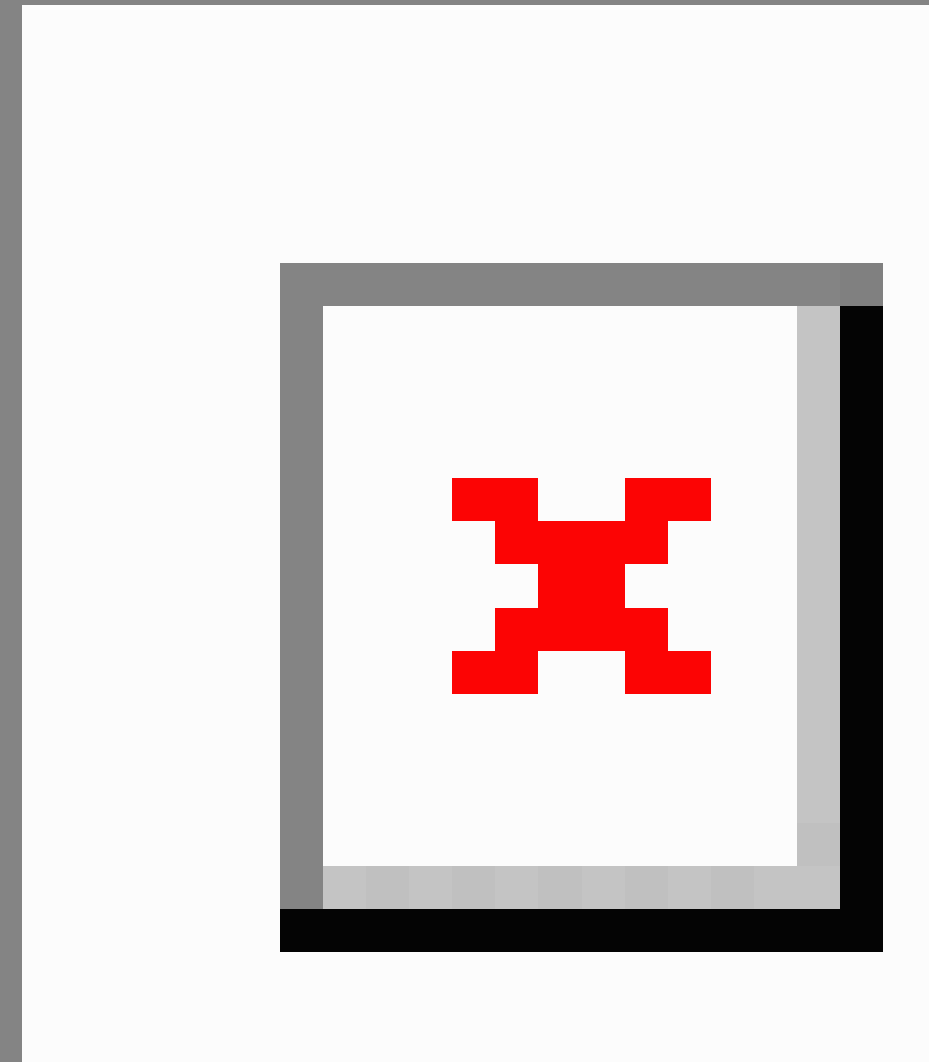
Figure 1. Health communication